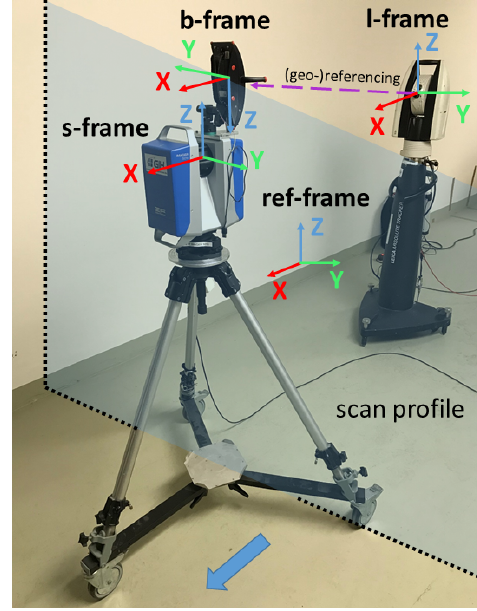
Figure 1. K-TLS based MSS consisting of a laser tracker (Leica AT960) and T-Probe for (geo-)referencing and laser scanner mounted on the mobile